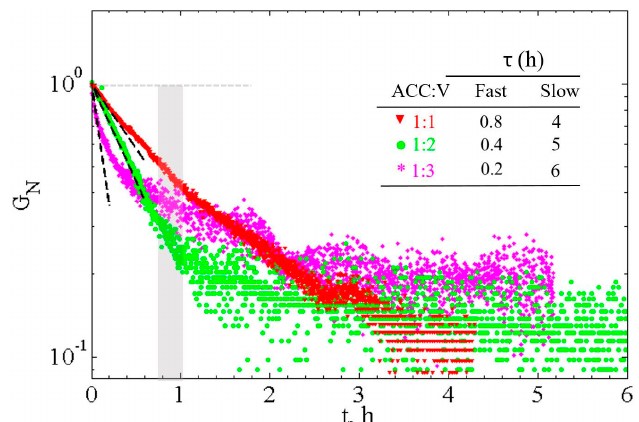
Figure 5. Time evolution of the normalized storage modulus, G N ’ , for three different CaCO 3 cement compositions (ACC:V 1:1, 1:2 and 1:3) measured from the time evolution of the elastic modulus. The average characteristic reaction times, τ i , are also included.